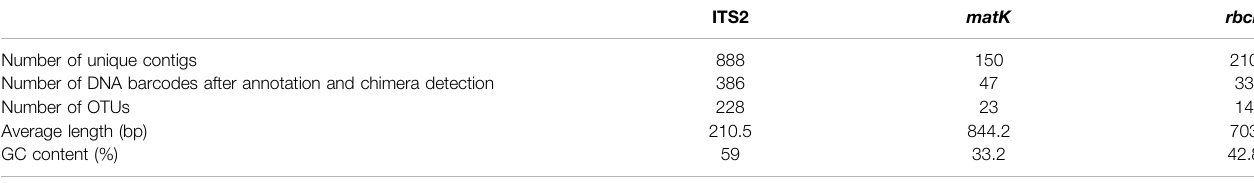
TABLE 3 | The assembly results of three DNA barcodes in the FKDSW samples.